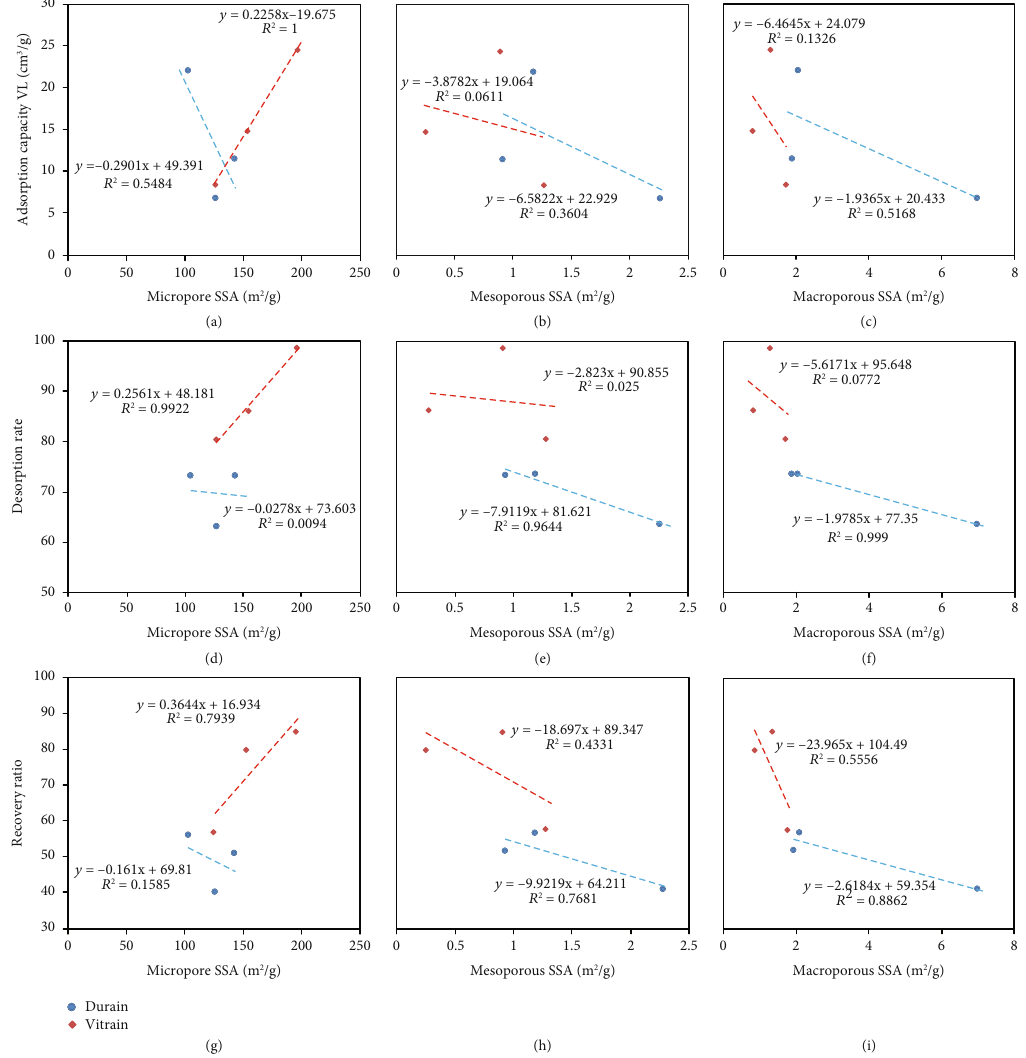
Figure 16: Correlationbetween(a)adsorptioncapacityandSSA,(b)betweenadsorptionrateandSSA,and(c)betweenrecovery